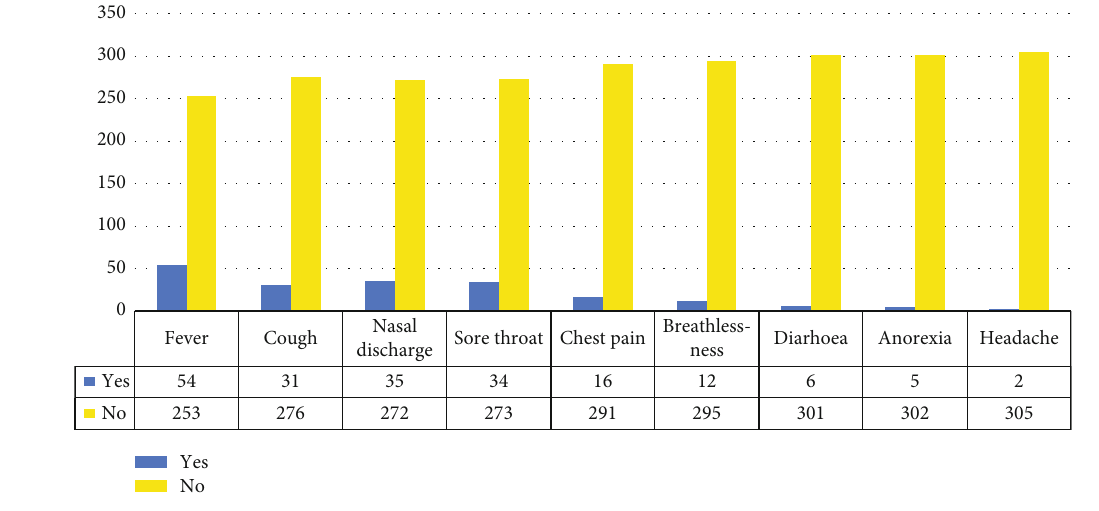
Figure 3: Symptomatology of the children screened for Table 2: Association between screening outcome and participants ’ characteristics.